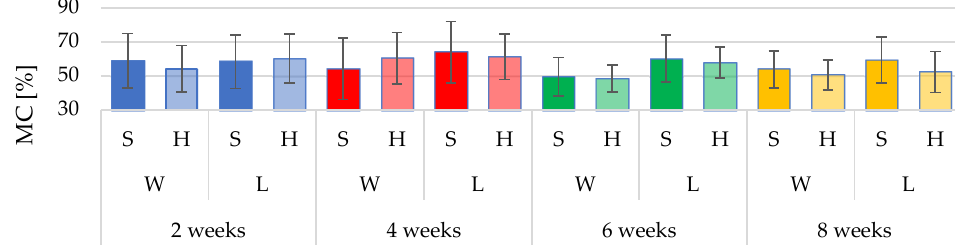
Figure 5. Mean and standard deviation of sapwood MC (sMC) and heartwood MC (hMC) according to storage duration, and storage methods. S–sapwood; H–heartwood; W–scenario W (whole trees); L–scenario L (stemwood).